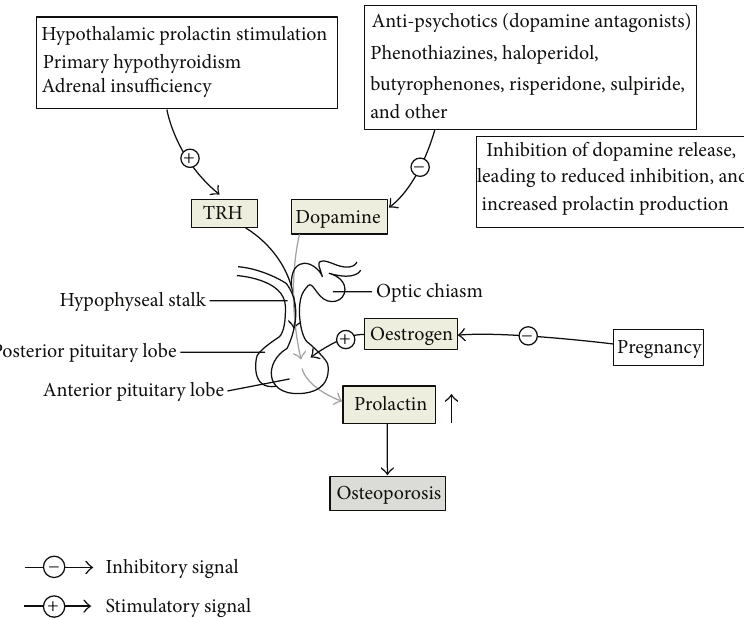
Figure 1: The physiological of antipsychotic-induced